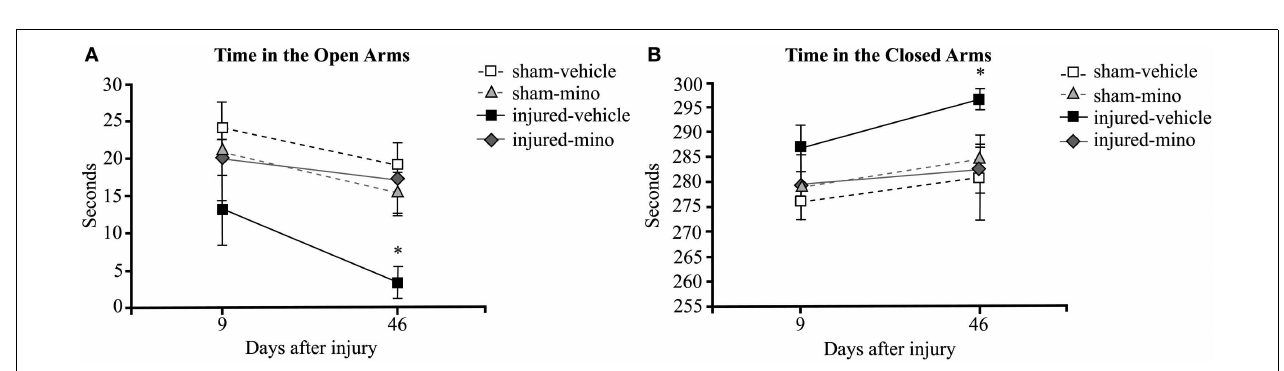
FIGURE 2 |The effect of injury and minocycline treatment on anxiety levels at different time points after mbTBI. (A) Time spent in the open arms (seconds), and (B) time spent in the closed arms (seconds) were measured for all animals in the elevated plus maze. Data are presented as mean ± SEM. * p < 0.05 for injured-vehicle vs. sham-vehicle